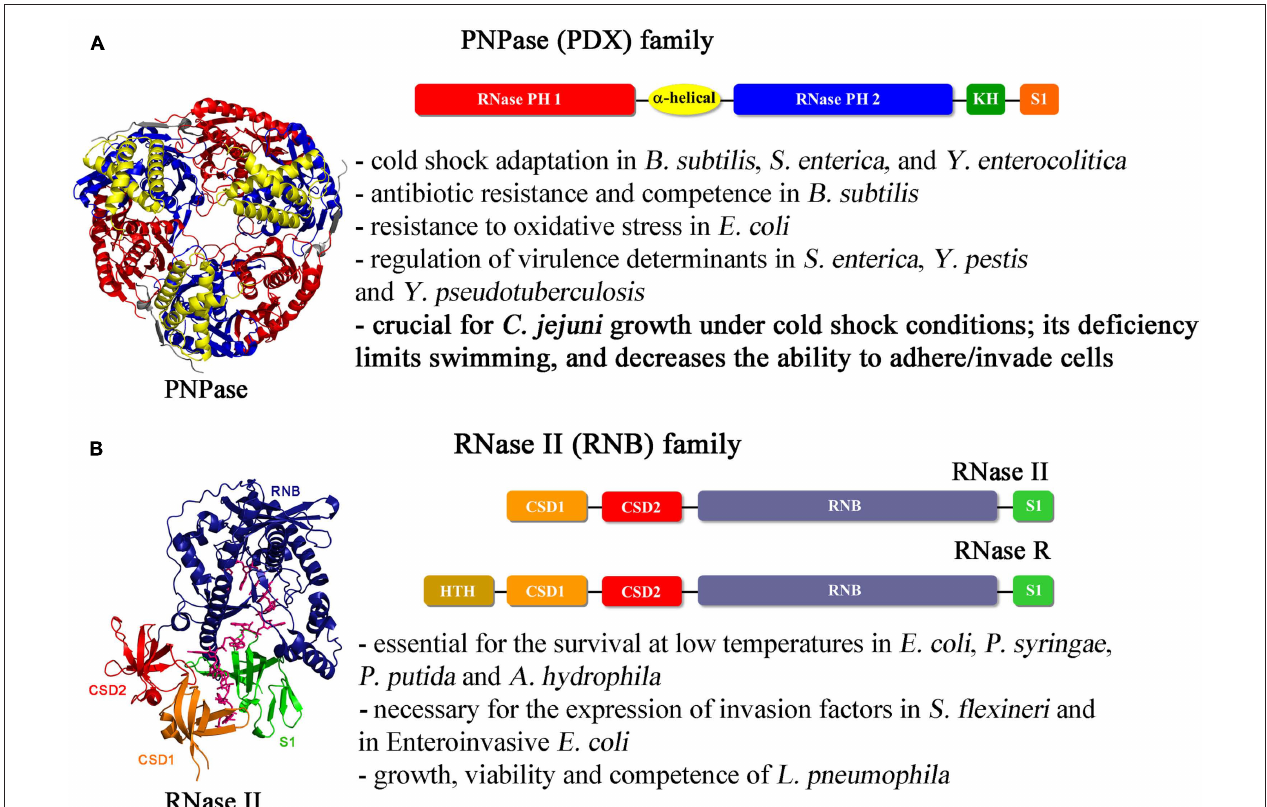
FIgure 1 | Schematic representation of the domains found in the exoribonucleases from PNPase and rNase II families and structures of representative members. (A) Top: PNPase (PDX family) primary structure: two RNase PH catalytic domains followed by two RNA binding domains (KH and S1). PNPase is a trimer and assembles in a donut like shape (on the left; Shi et al., 2008). The S1 binding domain was shown to restore PNPase deletion effect in Yersinia (Rosenzweig et al., 2007). (B) Top: linear representation of RNase II and RNase R domains: the central catalytic